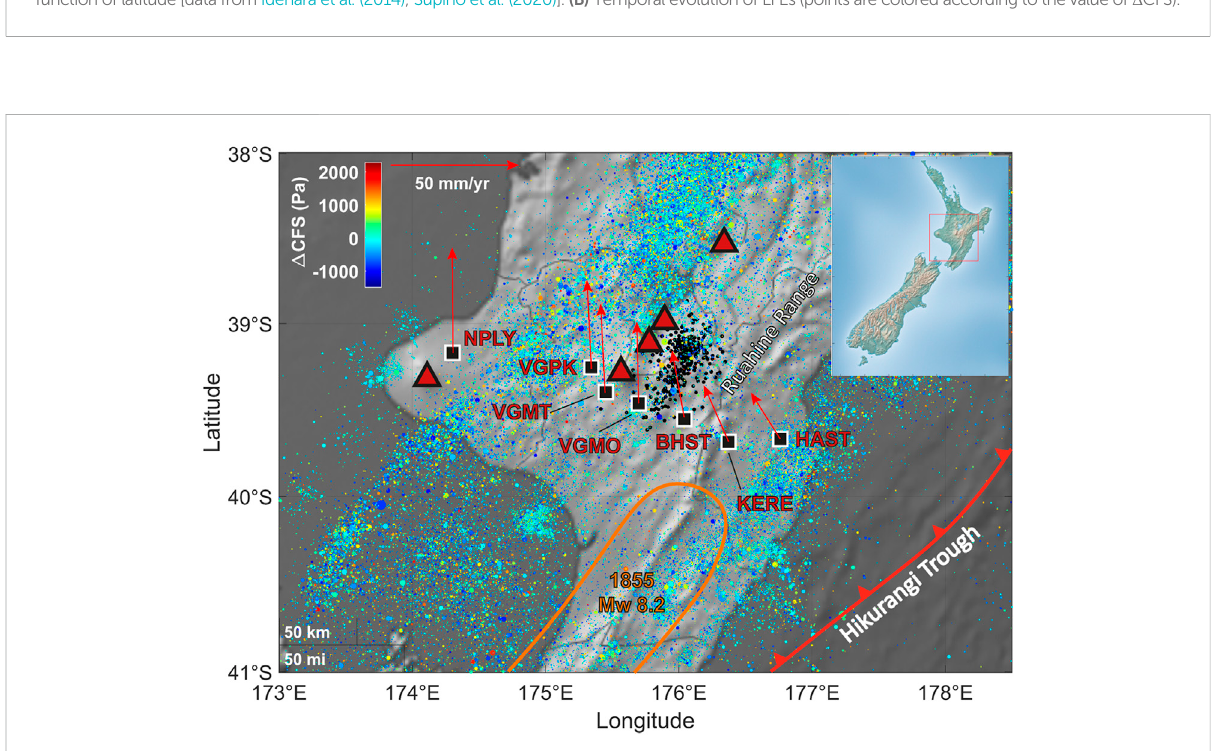
FIGURE 7 Map of seismicity in Manawatu, North Island, New Zealand, GNS Science earthquake catalog at https://quakesearch.geonet.org.nz (last accessed July 2022), 2000 – 2021, M L ≥ 2.5. Each earthquake is represented as a point whose color depends on the value of the Δ CFS at which it occurred, according to the color bar. Black points are tremors. Seven GNSS stations located along the dip with respect to the Hikurangi subduction zoneareplottedonthemapwiththelocalvectorvelocity(redarrows)providedbyNGL[MIDAScomponents,Blewittetal.(2018)].Redtriangles represent volcanoes, while orange contours qualitatively highlight fault patches broken by large